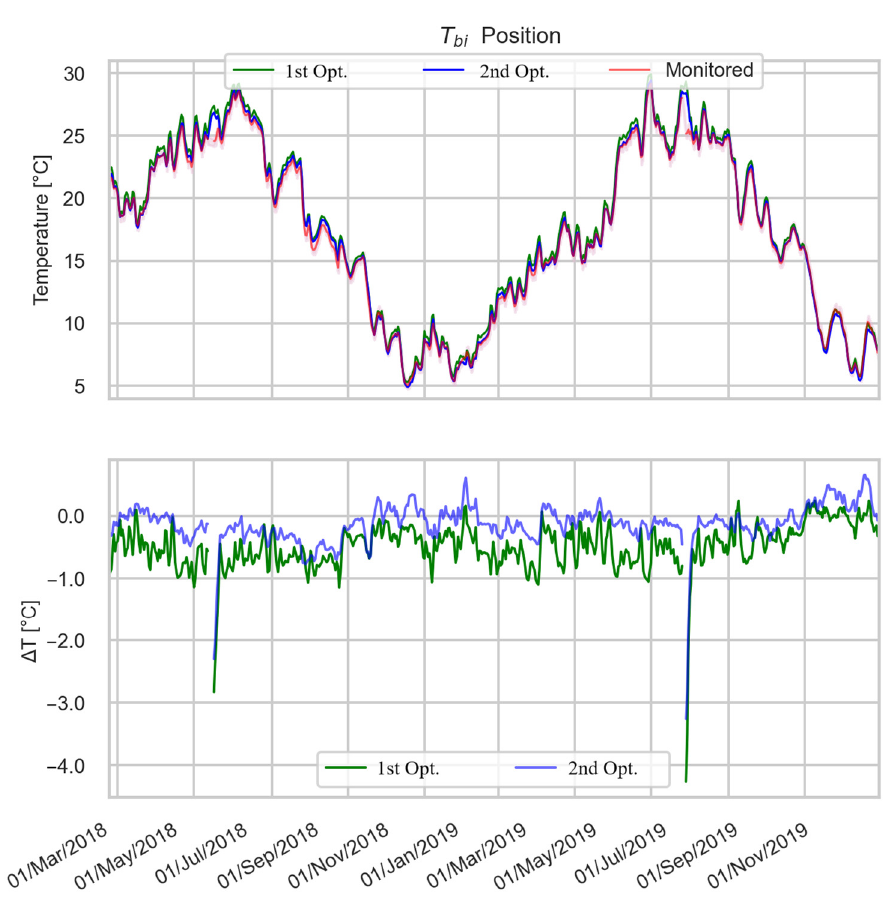
Figure 9. Comparison of the curve of the monitored temperature values at position T bi (in red including the shadow air of the measurement uncertainty) with the curve of the first optimized simulation (in green) and the second optimized simulation (blue).